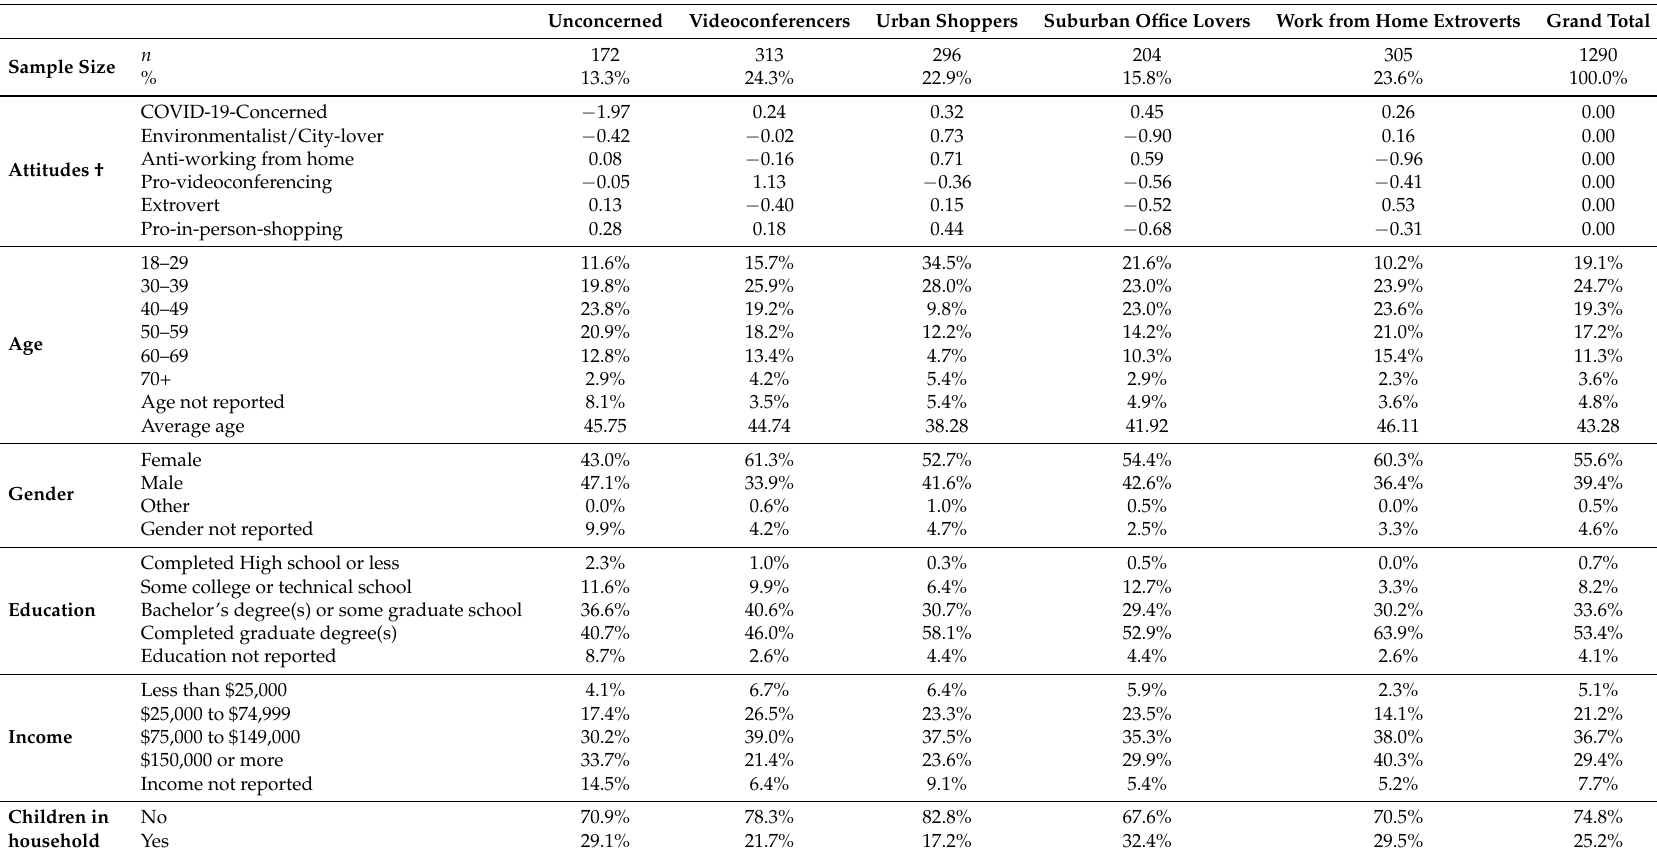
Table A3. Description of attitudinal cluster analysis